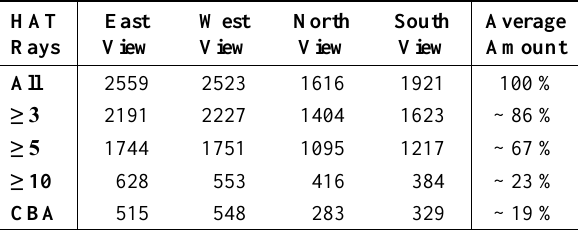
Table 5. Number of connection points used in different hierar- chical AT configurations in the Heilbronn block.